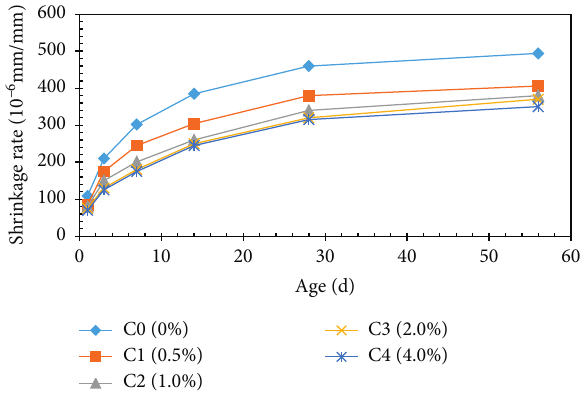
Figure 9: Effect of SRA dose on concrete shrinkage.